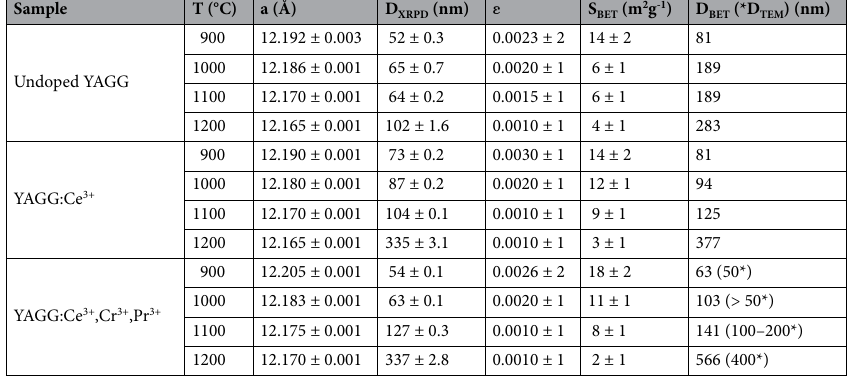
Table 1. Cell parameter a , crystallite size D XRPD and lattice microstrain ε obtained by applying the Rietveld method to the XRPD patterns; specific surface area S BET and particle size (D BET , D TEM ) of the